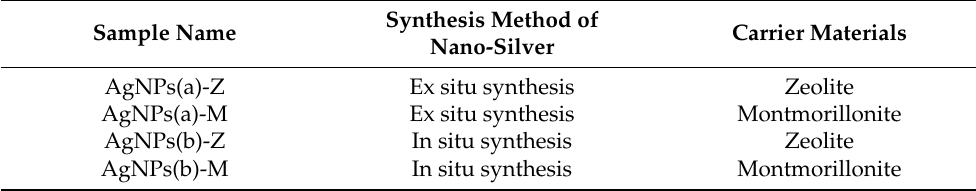
Table 1. Description and statement of prepared antimicrobial